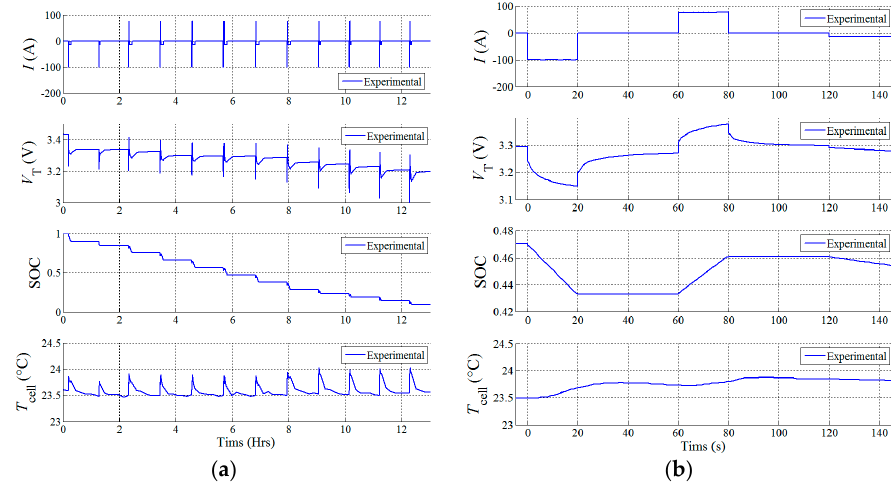
Figure 2. (Hybrid Pulse Power Characterization) HPPC test conducted to identify parameters at different SOC with ( a ) the entire process and ( b ) a zoomed-in profile at 47%.